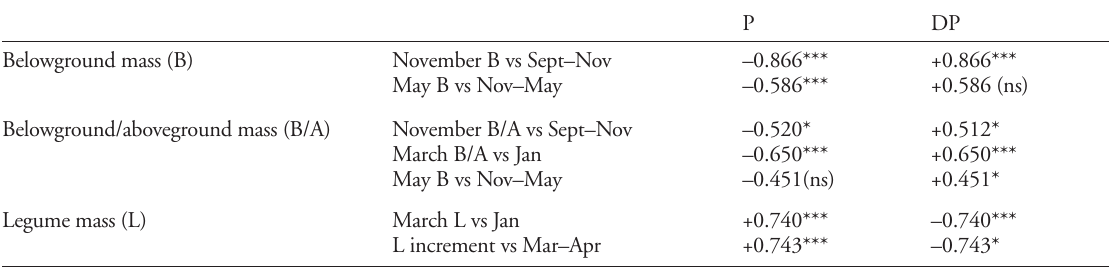
Table 3. Multiple linear regressions with the climate variables rainfall (P) and dry period (DP) explaining variations of biomass. Regres- sion coefficients for P and DP are reported. *p < 0.05, ** p < 0.01, ***p < 0.001, ns: not significant.